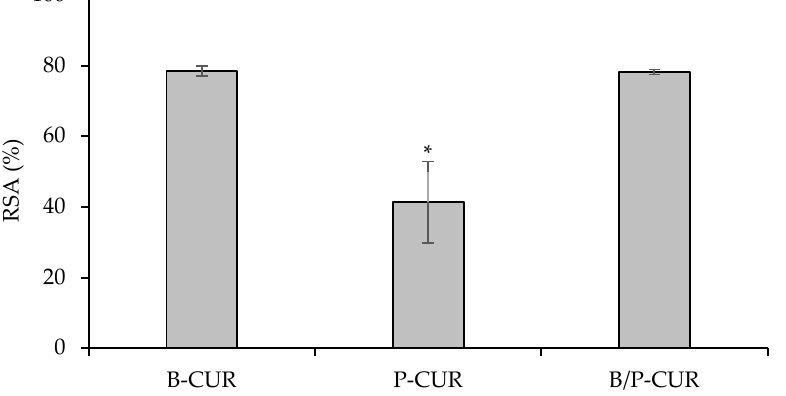
Figure 8. Radical scavenging activity (RSA%) of curcumin released from B-CUR, P-CUR, and B/P- CUR hydrogels (mean values ± s.d.; n = 3). * indicates significant differences ( p < 0.05).